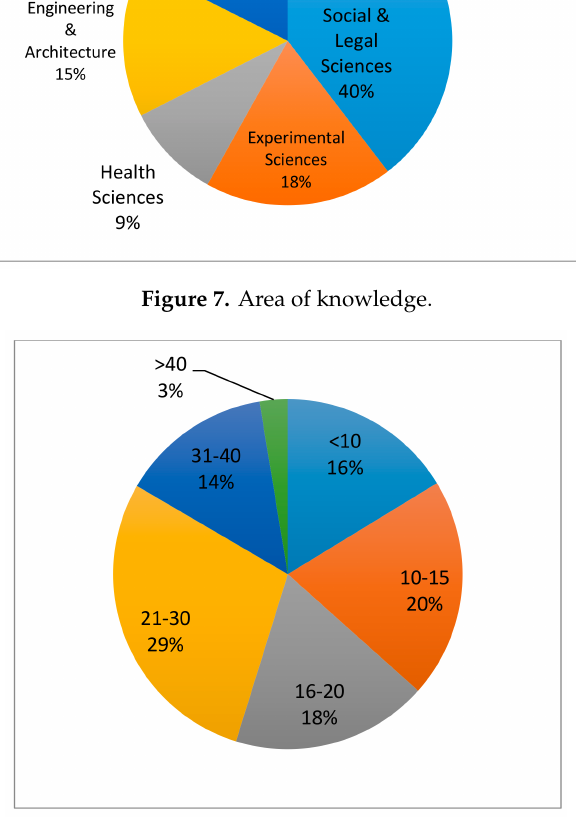
Figure 8. Years of